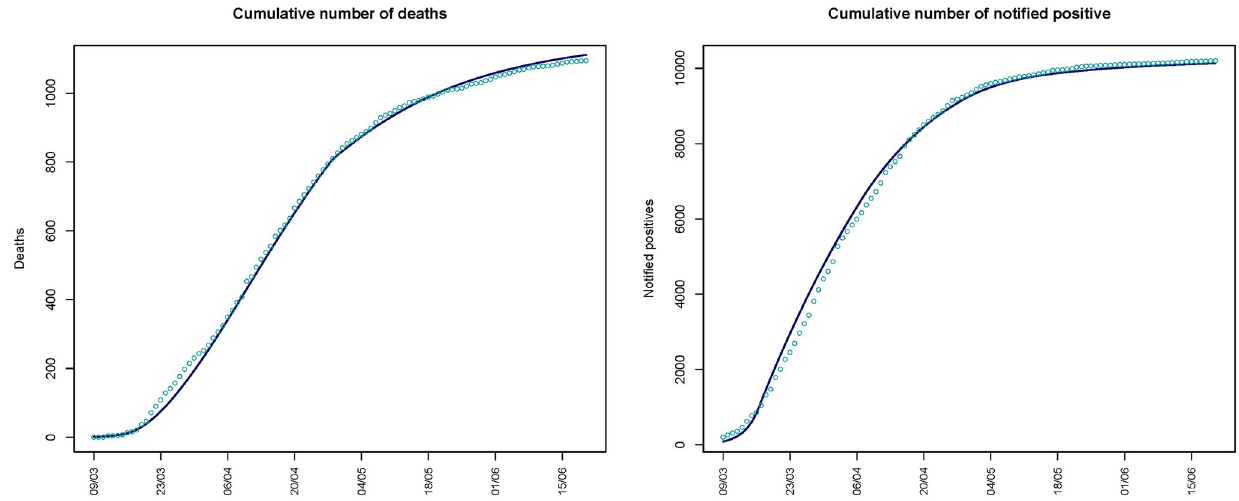
Fig 3. Cumulative number of deaths and number of notified infected circulating in the region estimated from the SI 2 R 2 D model (continuous lines) and observed (points).